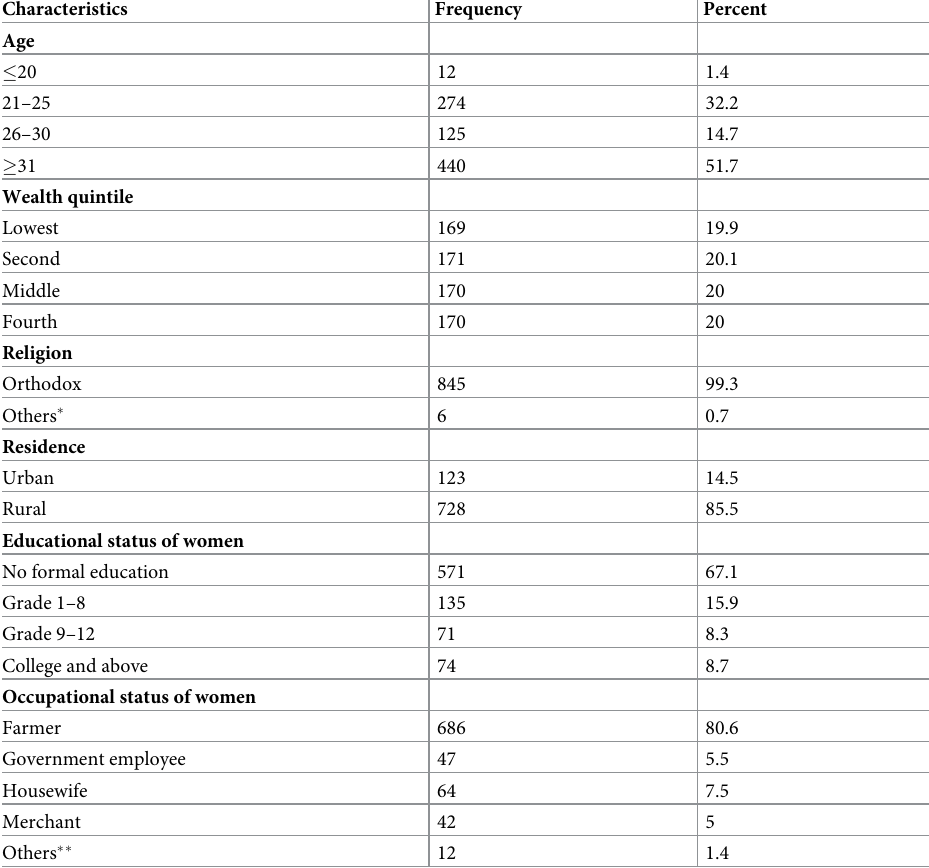
Table 1. Socio-demographic characteristics of study participants in Motta town and Hulet Eji Enese district, Northwest Ethiopia, 2021(n = 851).